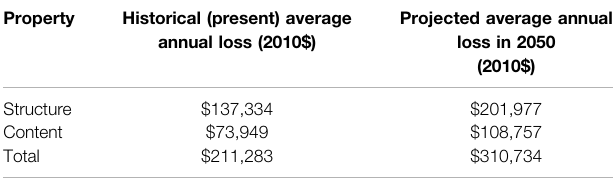
TABLE 1 | Comparison of Louisiana statewide property loss: Historical (present) vs. 2050-projected; All represent a 47.07 percent increase by 2050. Property